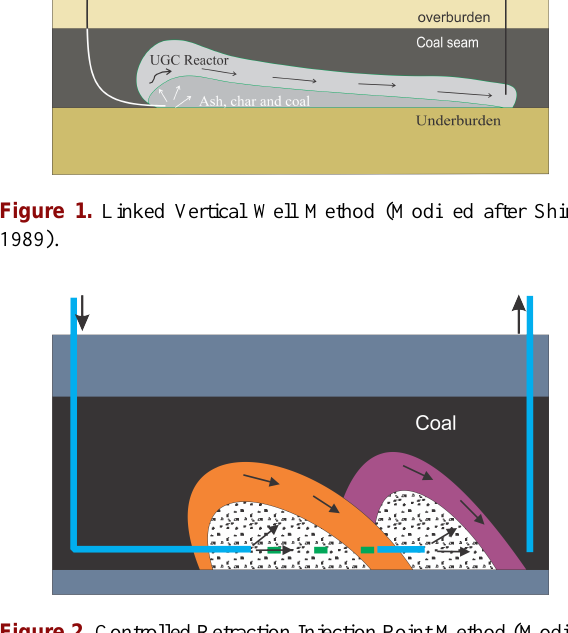
Figure 2. Controlled Retraction Injection Point Method (Modified after Bell et al.,